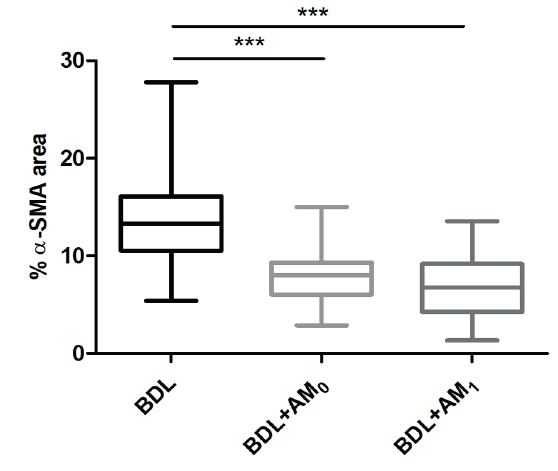
Figure 6 - Quantitative evaluation of α-SMA area. Median and interquartile range of α-SMA area in the experimental groups after 6 weeks of BDL.